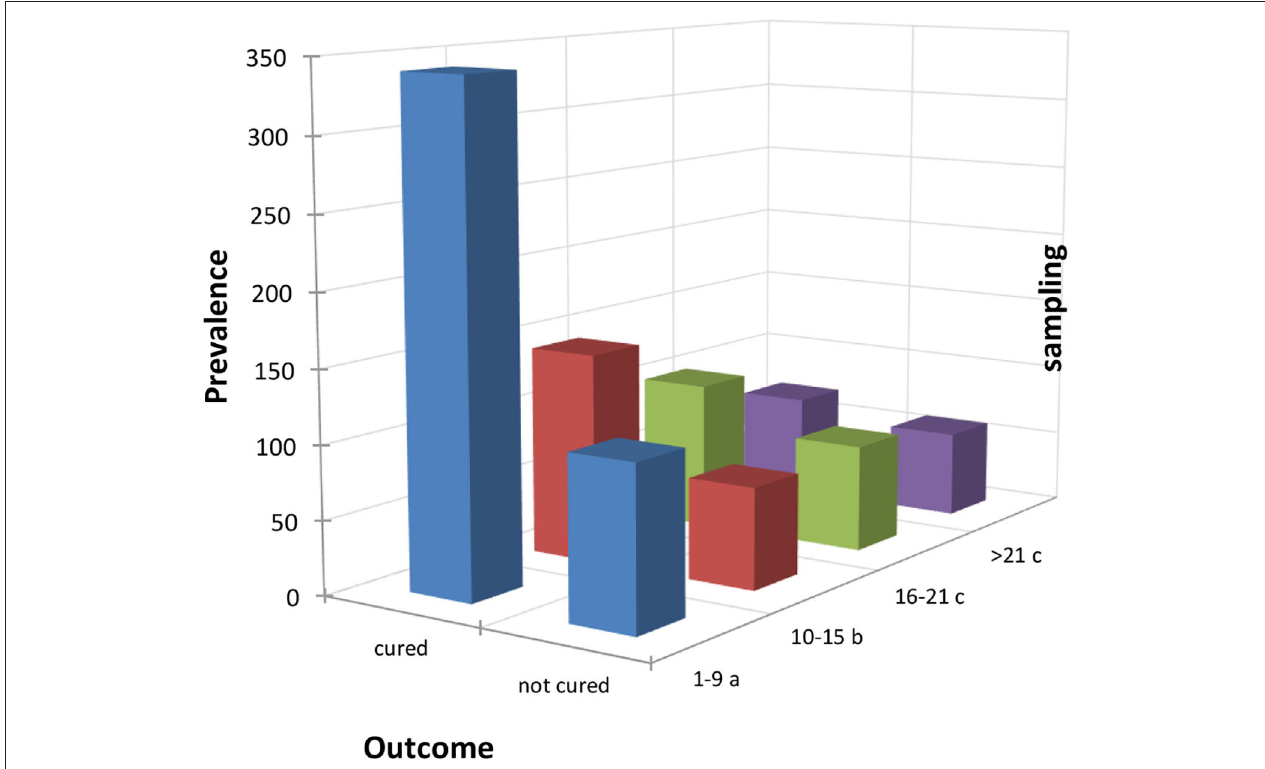
FIGURE 1 | Distribution of the outcomes of the treated cows within the four sampling periods considered (periods 4 and 5 were added up to have a consistent number of samples). Letters denote the differences between expected and observed results based on χ 2 test as follows: (a) significantly higher frequency of cure at α = 0.05; (b) no statistical differences, (c) significantly lower frequency of cure at α = 0.05.